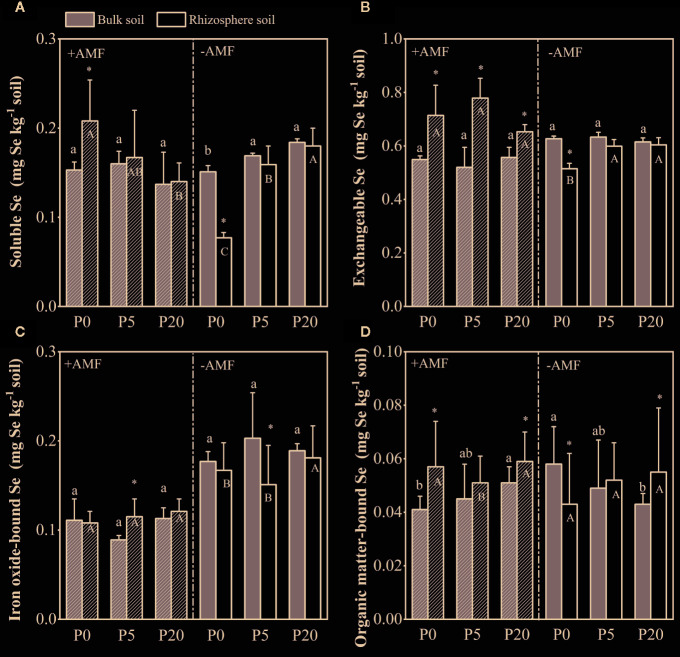
Sequential extraction results of selenium fractions in the bulk soil and rhizosphere soil. (A) Soluble Se; (B) Exchangeable Se; (C) Iron oxide-bound Se; (D) Organic matter-bound Se. Data are presented as means ± S.E. (n = 4). One-way ANOVA and Tukey’s test were performed for each Se fraction in the +AMF and −AMF treatments separately for the bulk soil and rhizosphere soil. Lower-case letters indicate significant differences between the bulk soil, and upper-case letters indicate significant differences between the rhizosphere soil. One-way ANOVA significance (P < 0.05) to test for significant differences between the bulk soil and rhizosphere soil for each treatment is indicated by *.